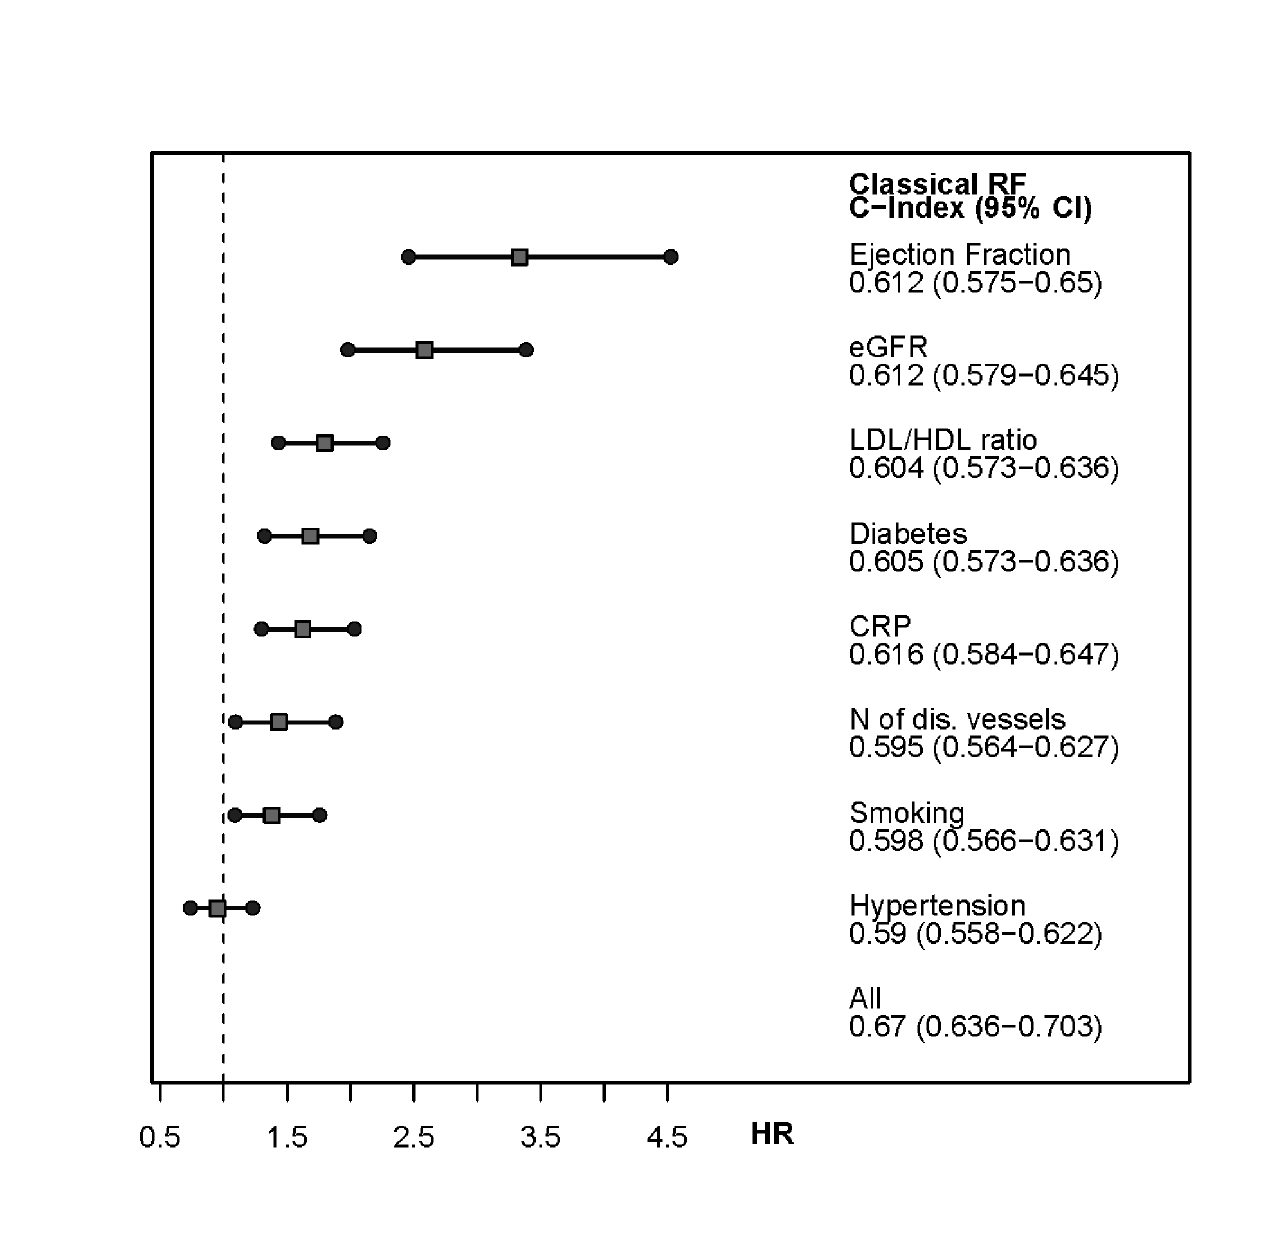
Fig 2. Hazard Ratio and C-Index for investigated risk factors (adjusted for age and sex) in the stable angina cohort. The hazard ratio and the C-Index are for the comparison cardiovascular event vs. no event during follow-up. In these figures creatinine clearance is represented by